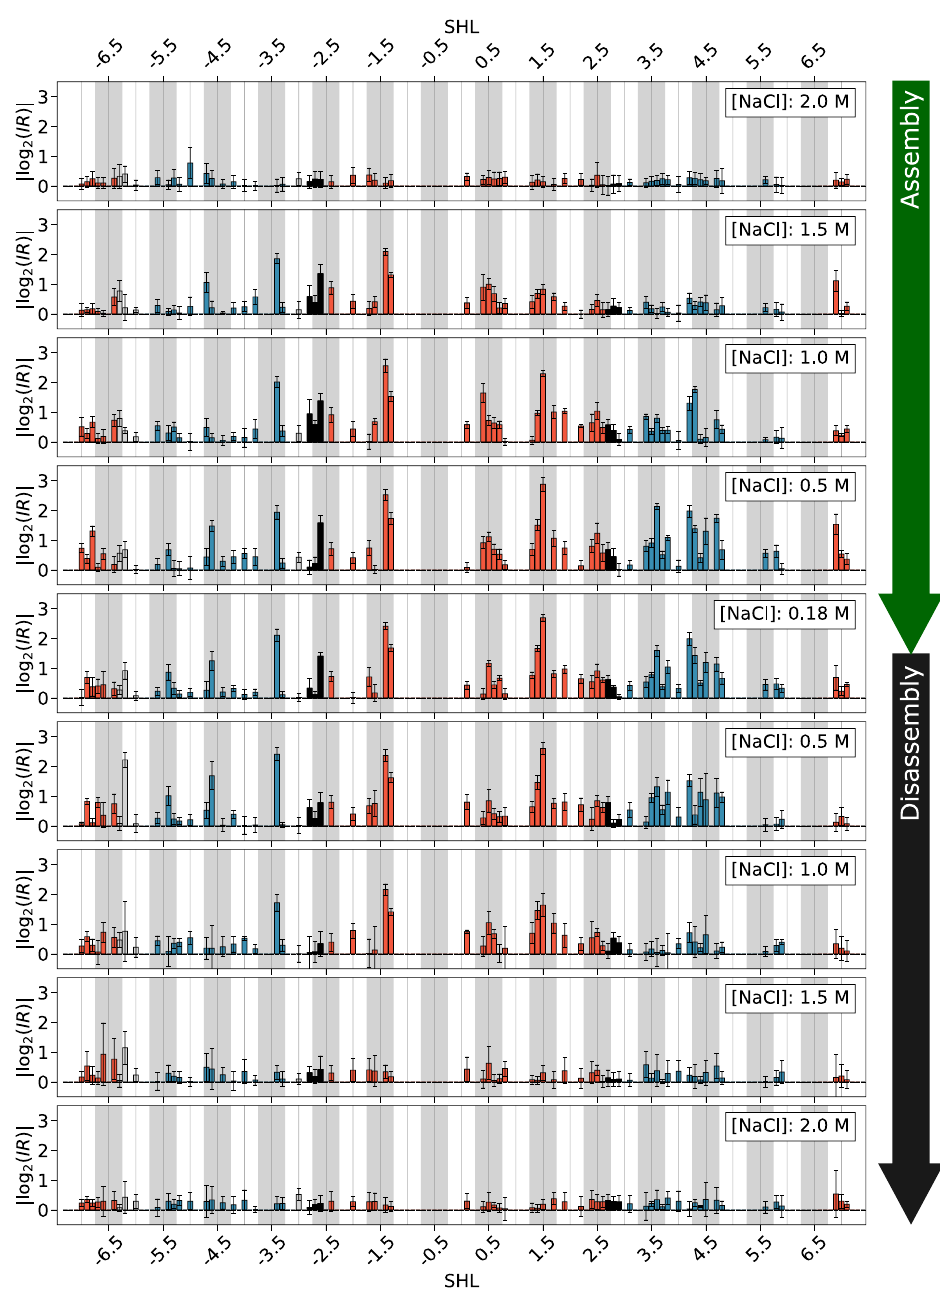
Fig 4. Changes in the probability of YpY dimer formation in DNA during nucleosome assembly and disassembly experiments. Changes in the probability of YpY dimer formation are presented in terms of absolute values of log2 of the intensity ratios (|log2(IR)|) along the 601 sequence expressed in SHLs; they are given for decreasing (top panel) or increasing (bottom panel) ionic strengths, as indicated by the green and black arrow respectively. The IR quantities are the ratios calculated between the normalised peak heights associated with each YpY step in the histone plus DNA mixtures and those of DNA alone. Red and blue bars correspond to DNA residues involved in the interface with H3/H4 and H2A/H2B dimers, respectively; black bars correspond to dinucleotides contacted by the two dimers. Minor-groove inward facing regions observed in the nucleosome structures are represented by grey boxes. Error bars are first-order estimations of standard errors calculated on at least 3 independent experiments (see Material and Methods for